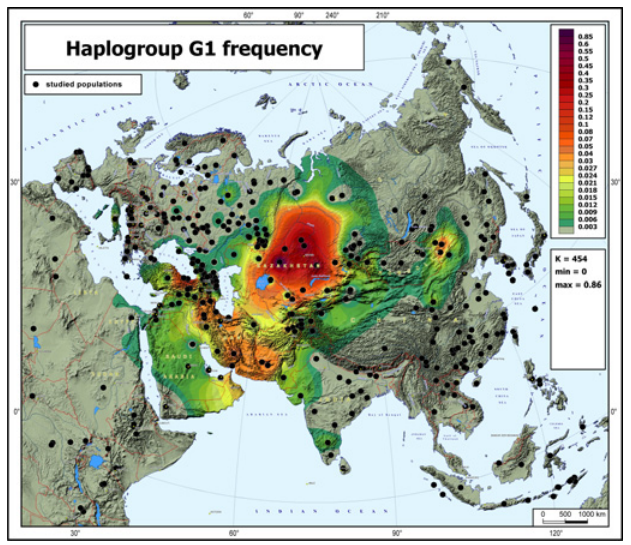
Fig 2. Frequency distribution map of haplogroup G1. The black points represent the populations analyzed. Abbreviations in the statistical legend indicate the following: K, number of the populations studied; MIN and MAX, the minimal and maximum frequencies on the